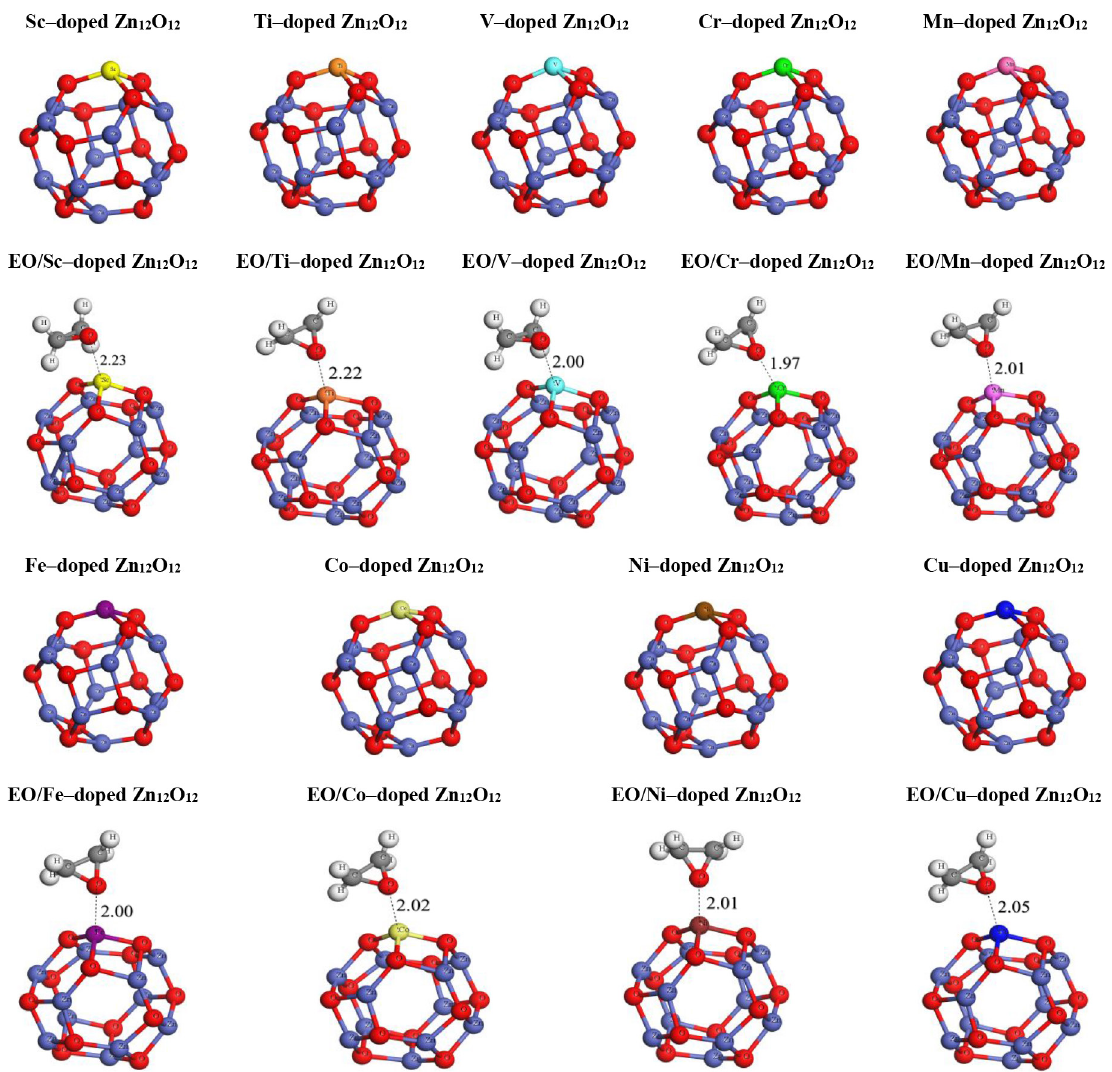
O and their adsorbed complexes with EO molecule. Distances are in 12 12